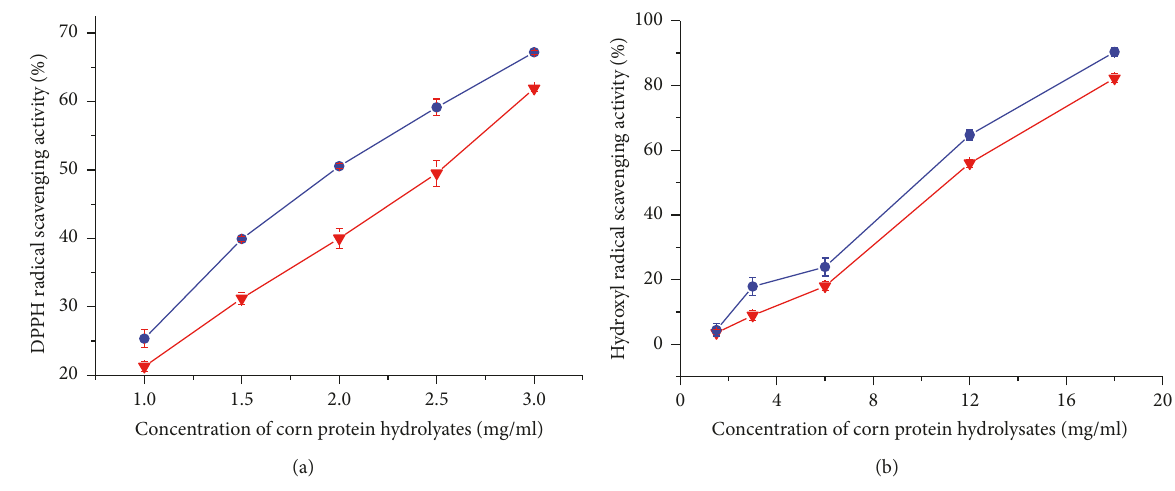
Figure2:AntioxidantcapacitiesofcornproteinhydrolysatesonDPPHradicalscavengingactivity(a)andhydroxylradicalscavengingactivity (b). Ultrasonic ( e ); control ( 󳶃